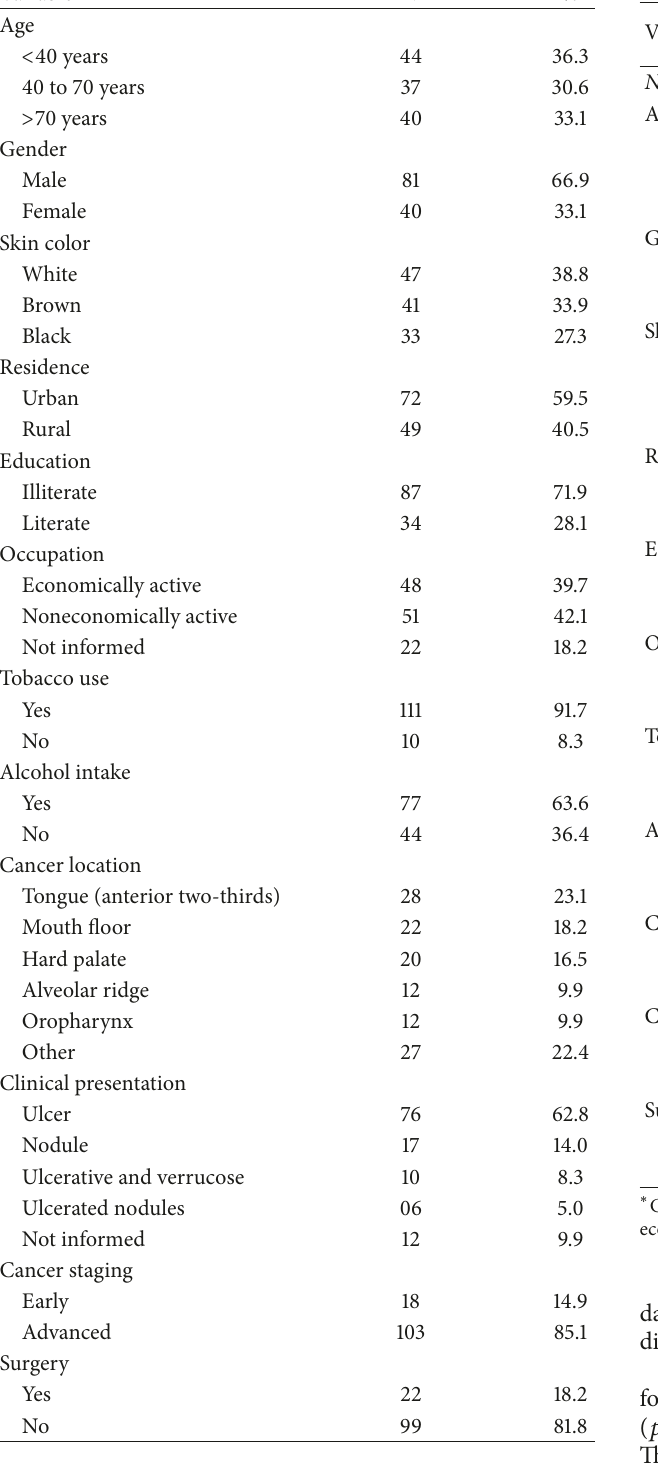
Table 1: Sociodemographic and clinical characteristics of the 121 patients.